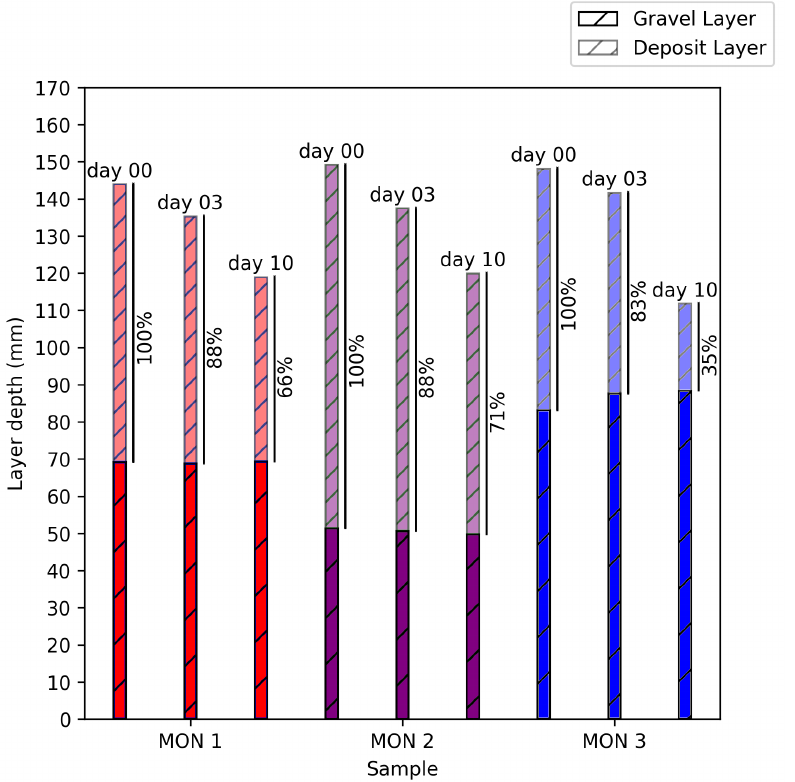
Figure A1. Evolution of deposit and gravel layer thicknesses during the drying experiment: compu- tations were performed for an ROI of 60%.